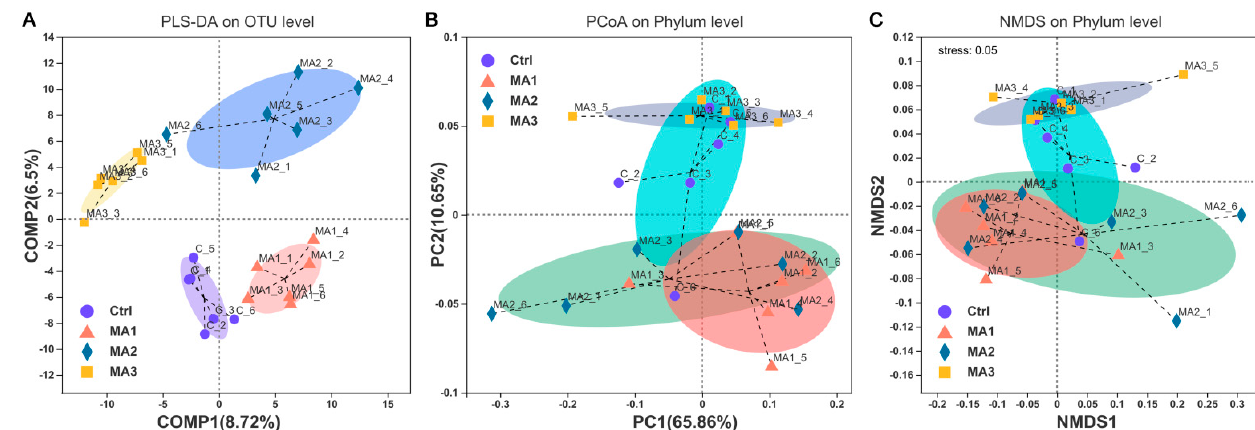
Figure 2. The β − diversity of cecal microbiota of broilers. ( A ) Partial least squares discriminant analysis (PLS-DA) on operational taxonomic unit (OTU) level. ( B ) Principal coordinate analysis (PCoA) of weighted distance calculated from phylum abundance matrix. ( C ) Nonmetric multidi- mensional scaling (NMDS) on phylum level. Ctrl: the control group; MA 1–3: the experimental groups fed the basal diets supplemented with 4, 8, and 12 g/kg of bio-fermented malic acid, re- spectively.